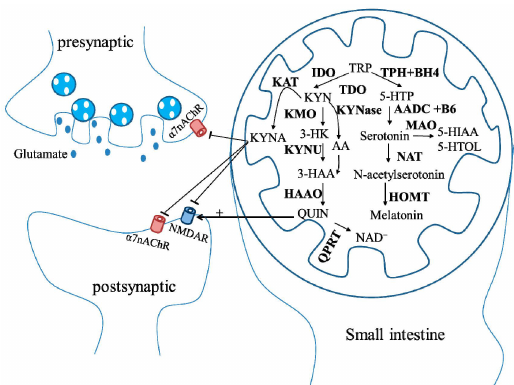
Figure 3. Schematic representation of the tryptophan (TRP) metabolic pathway. Most TRP is used